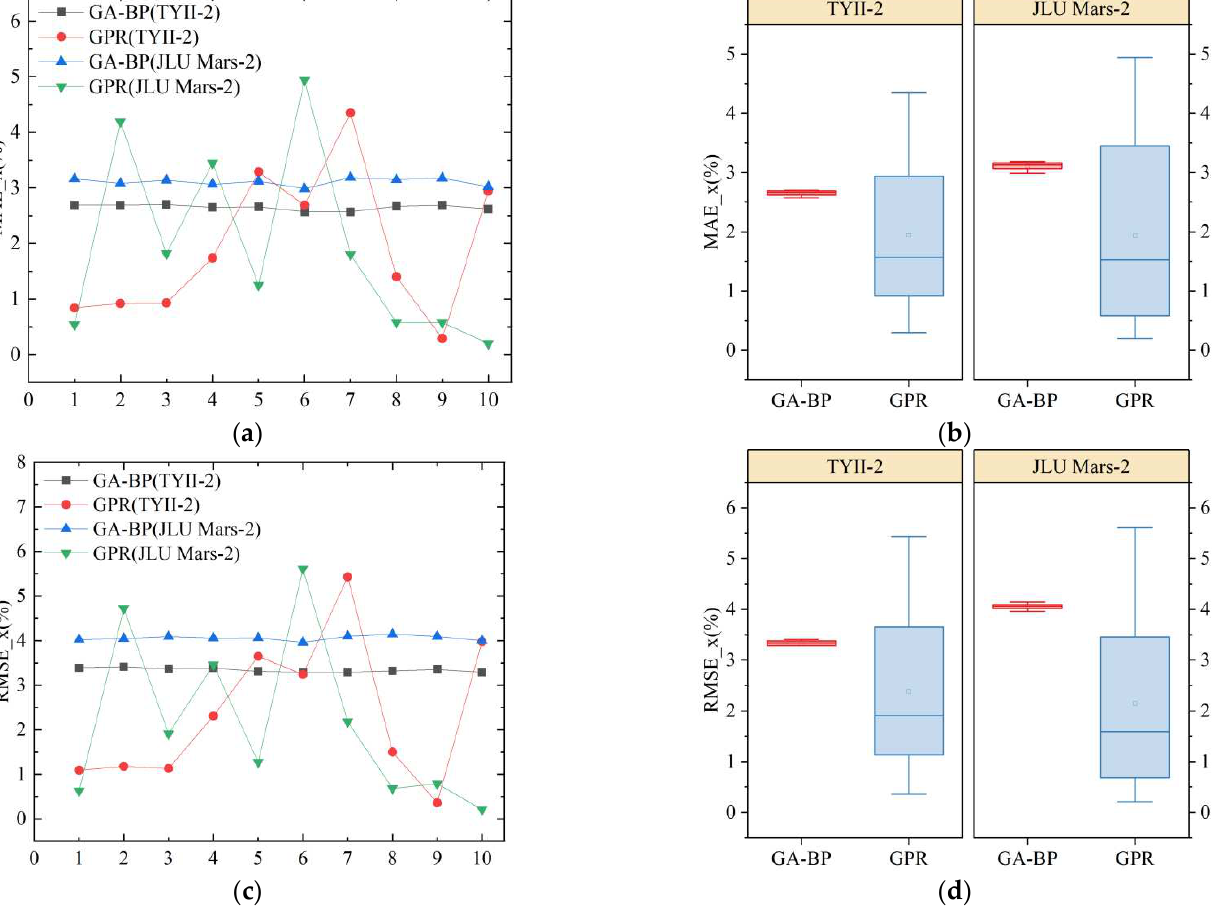
Figure 8. The estimation results of five test groups for slip_ x using GA-BP and GPR: ( a ) the line charts of MAE_ x ; ( b ) the box plots of MAE_ x ; ( c ) the line charts of RMSE_ x ; ( d ) the line charts of RMSE_ x . Table 4. Estimation results of GPR on TYII-2 and JLU Mars-2 (slip_ y ). TYII-2 JLU Mars-2